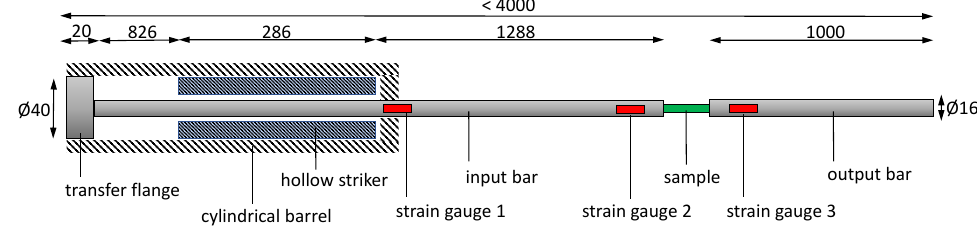
Figure 2. Sketch of the SHTB setup employed in this work. All dimensions are in mm. Input and output bars are 16 mm diameter aluminium rods. The striker is a hollow POM tube of 40 mm outer diameter and 16.1 mm inner diameter. Two strain gauges on the input bar to measure the incident wave [ ε inc ] and reflected wave [ ε ref ], and one on output bar to measure the transmitted wave [ ε tra